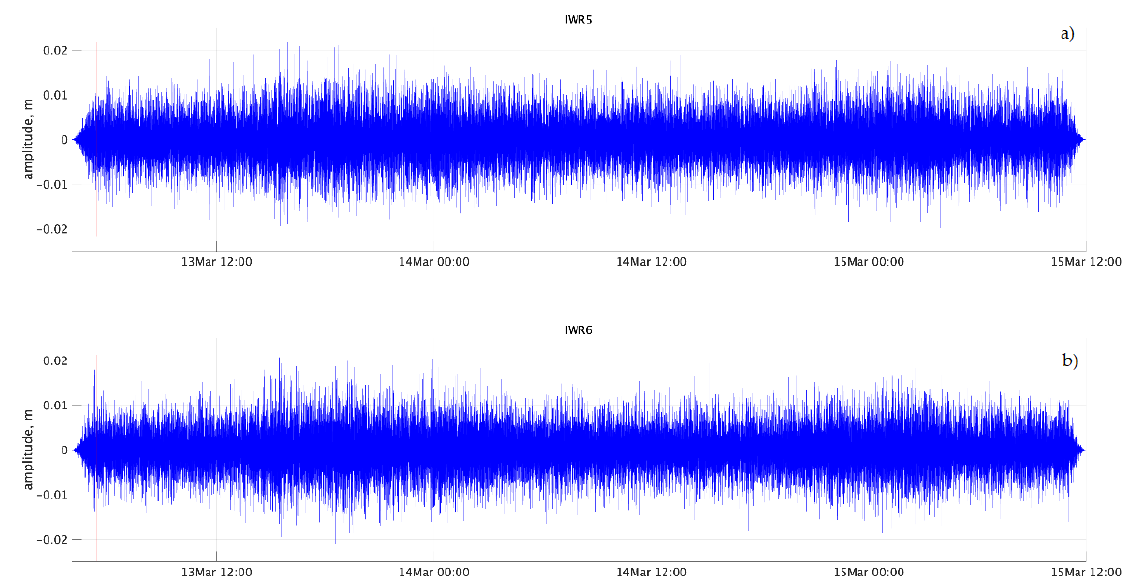
Figure 6. Vertical displacement timeseries in meters from early 13 March through noon 15 March 2020, for ( a ) IWR5 and ( b ) IWR6. The largest amplitudes exceed two centimeters. The beginning and ends have been tapered to